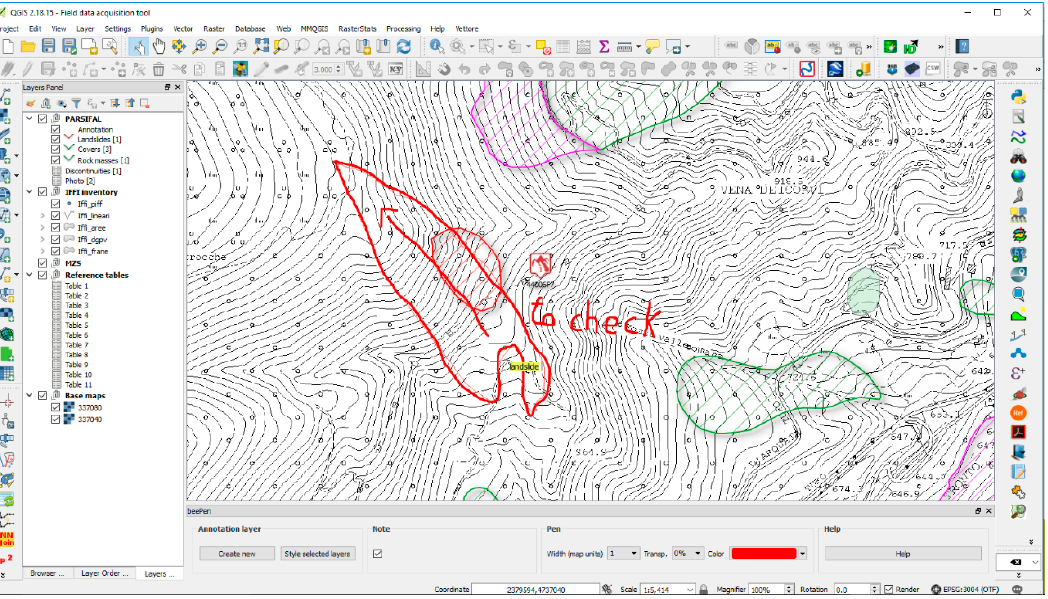
Figure 6. QGIS window with layers of the PARSIFAL project. The BeePen plug-in (at the bottom) allows sketches and annotations on the map, as shown.